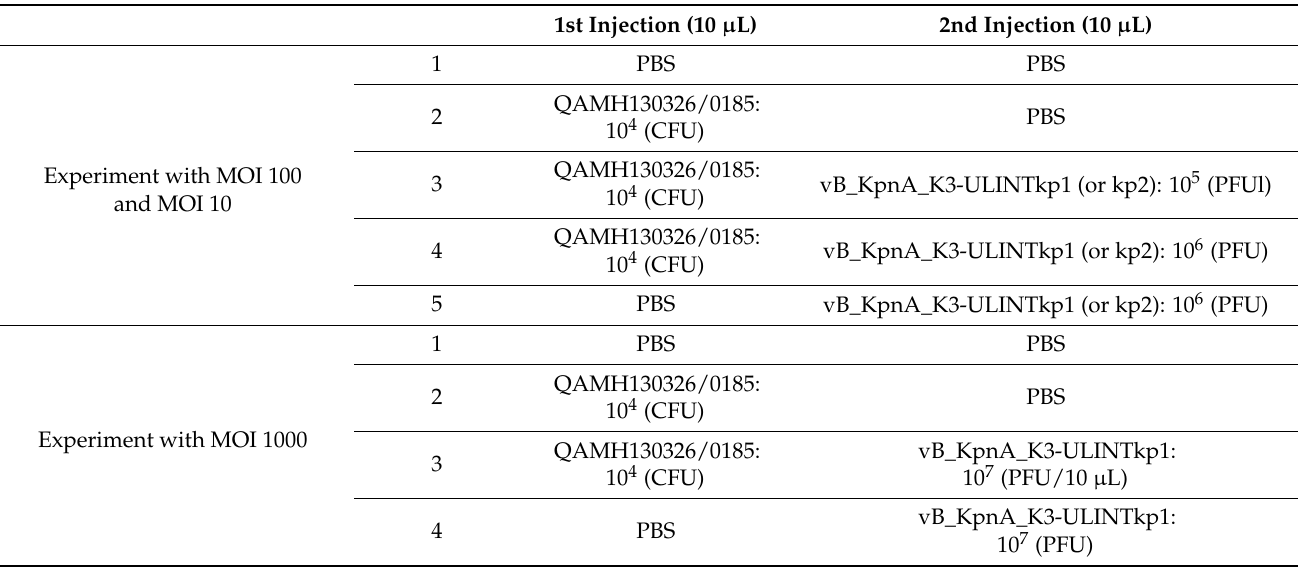
Table 1. Groups of G. mellonella larvae inoculated for the survival and titration experiments (MOIs of 10, 100 and